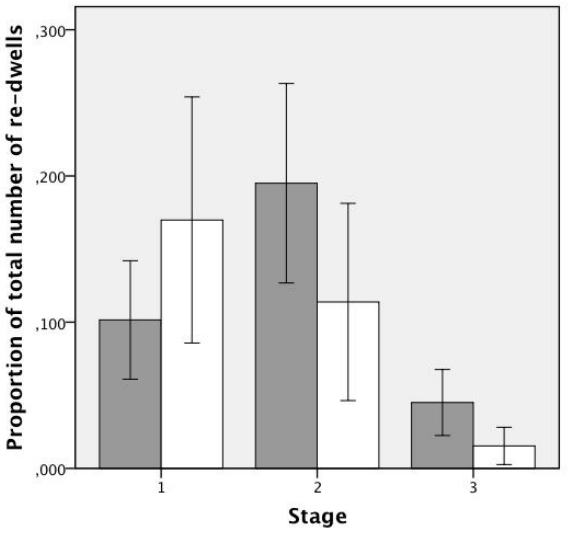
Figure 6. Proportion of total amount of re-dwells in each stage of the Natural Decision Segmentation Model. Grey bars represent decision task and white bars represent search task. Error bars +/- 2 SE.